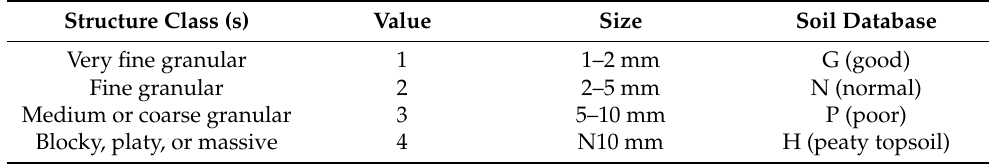
Table 4. Soil structure classes derived from the European Soil Database. Structure Class (s)